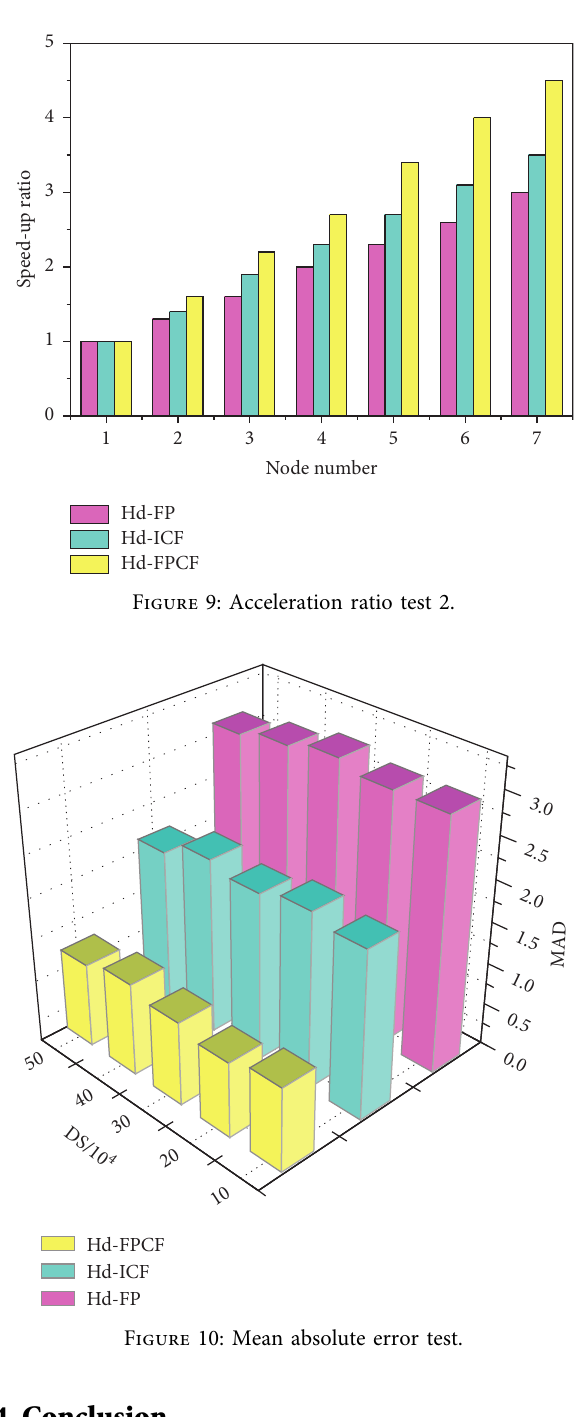
Figure 10: Mean absolute error